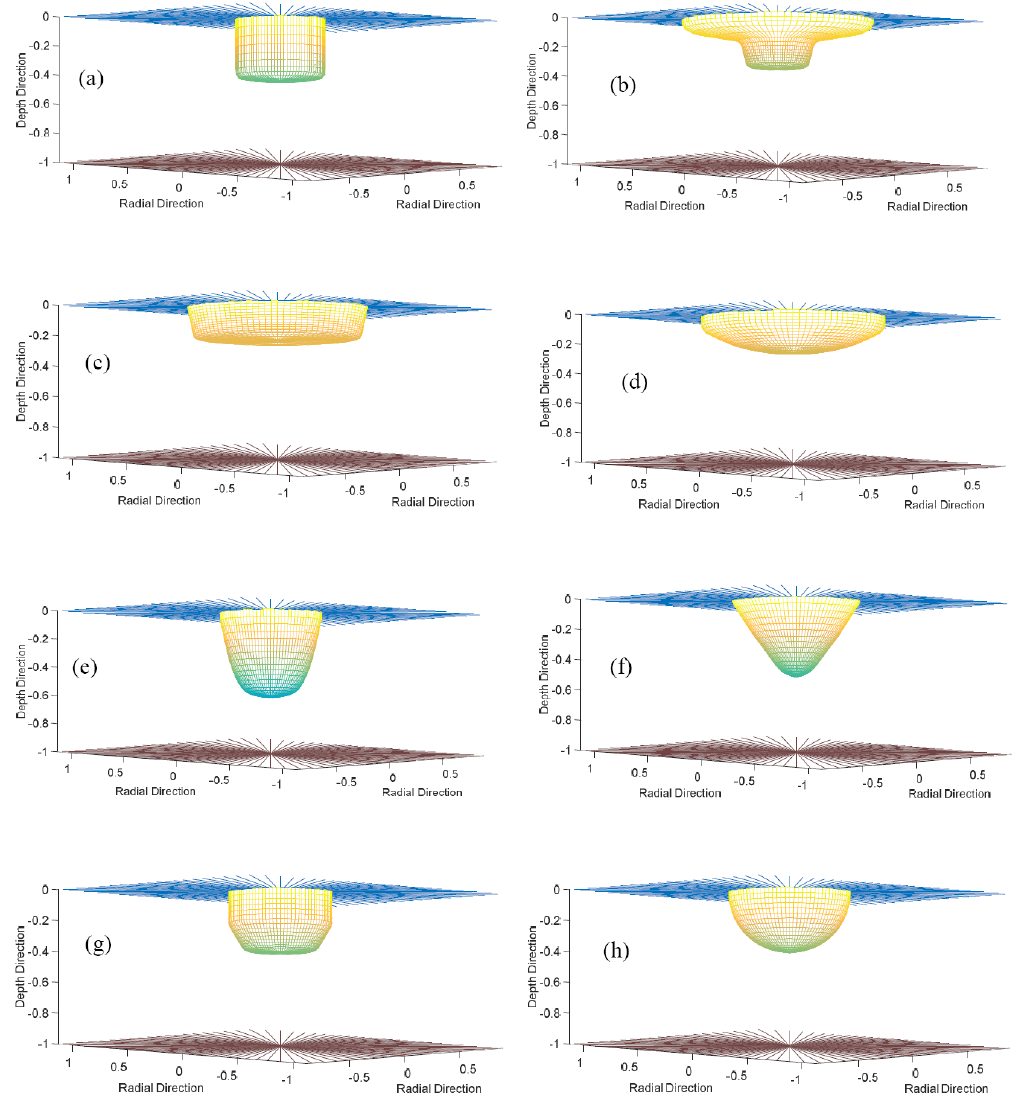
Figure 8. Various WEC shapes and near field computational mesh: ( a ) Cylindrical, ( b ) Nailhead-shaped, ( c ) Disk-shaped, ( d ) Elliptical, ( e ) Egg-shaped, ( f ) Conical, ( g ) Floater-shaped, ( h ) Semi- spherical.